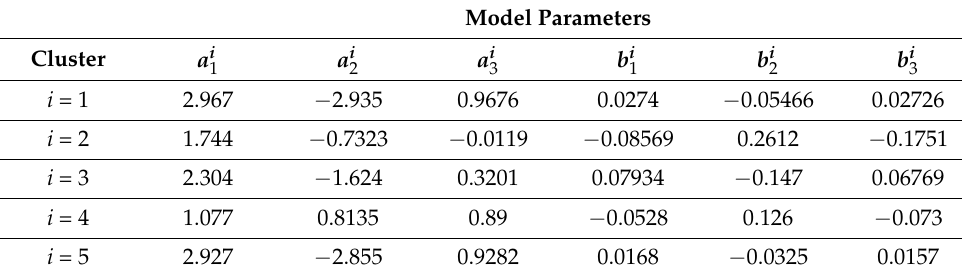
Table 1. The model parameters that are identified by the proposed method with τ = 0.2.